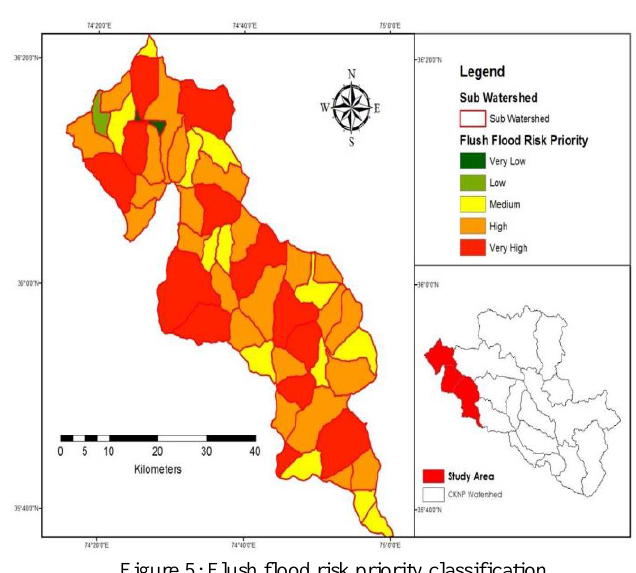
Figure 5: Flush flood risk priority